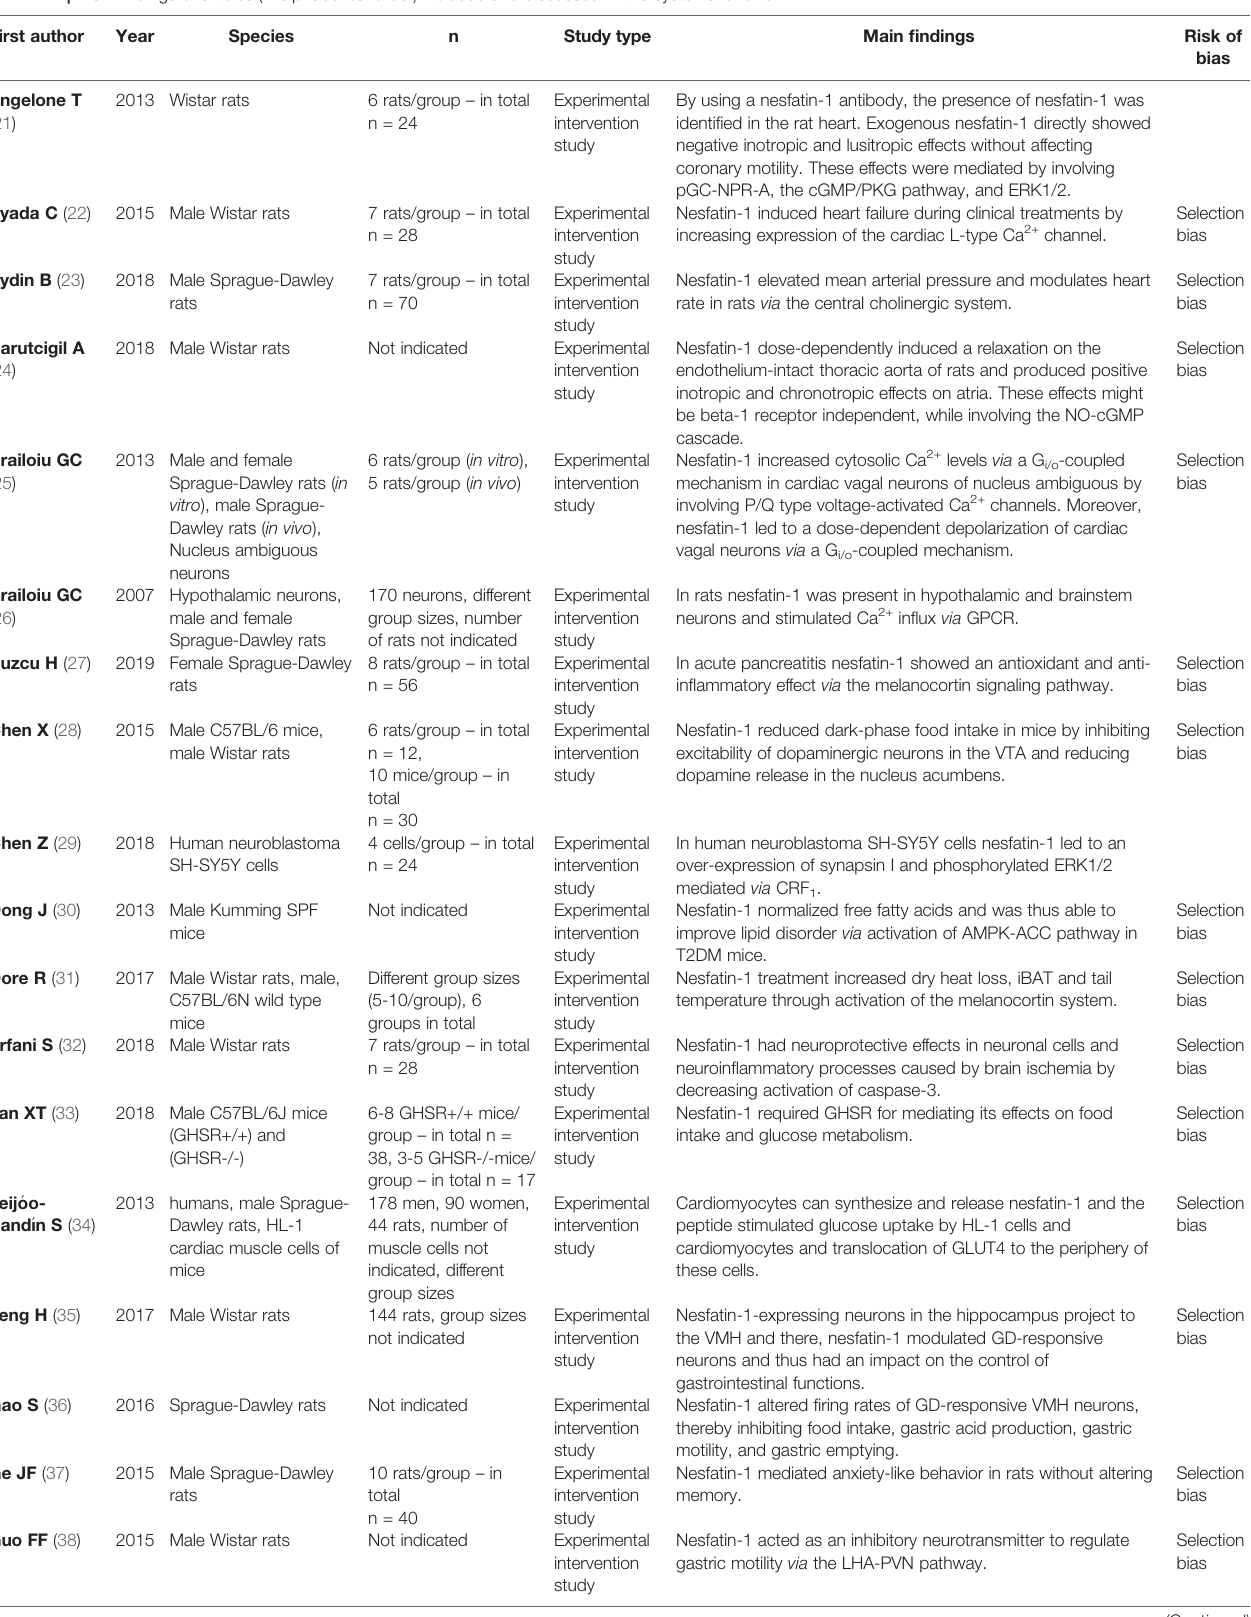
TABLE 2 | Main fi ndings of articles (in alphabetical order) included and discussed in this systematic